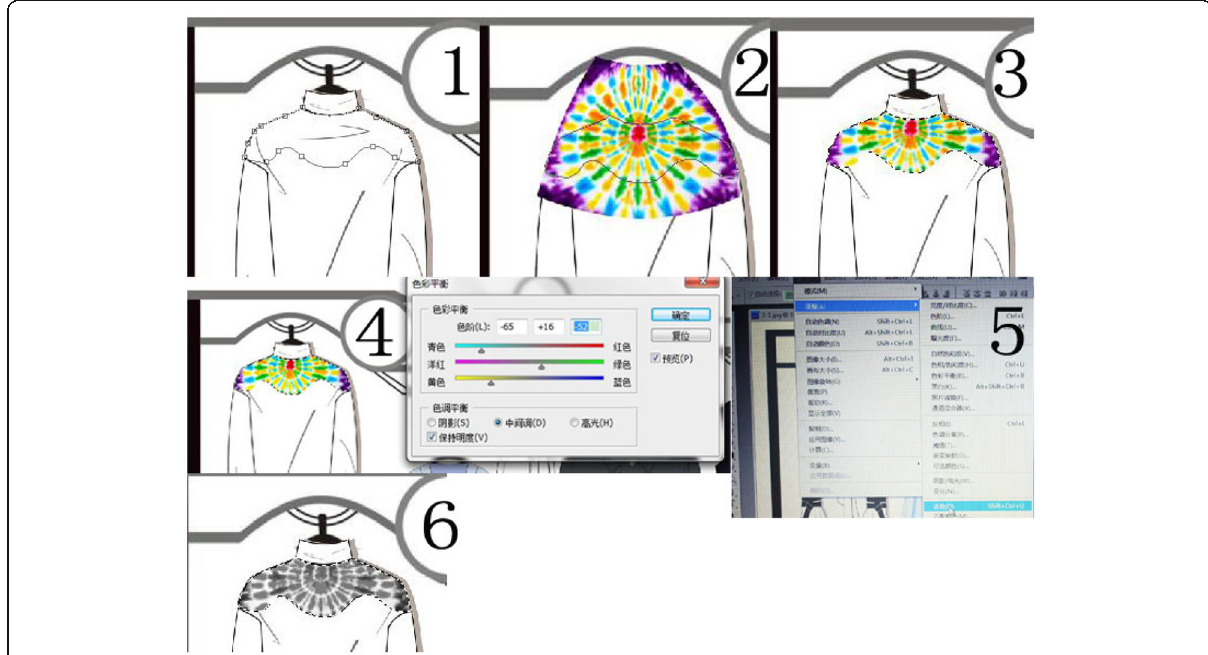
Fig. 3 Software operation process for recombining patterns based on the decomposition of original graphics. (The first kind of computer software technology is to recombine the pattern design according to the decomposition of the original graphics and to use the effect of forming a tie-dyed texture)